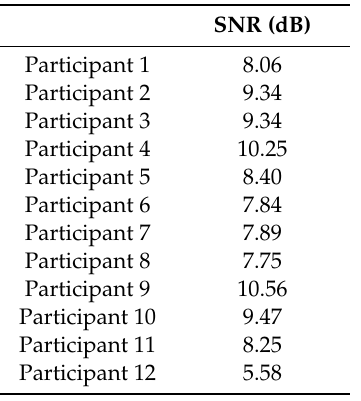
Table 1. Signal-to-noise ratio (SNR) of the audio data for the twelve